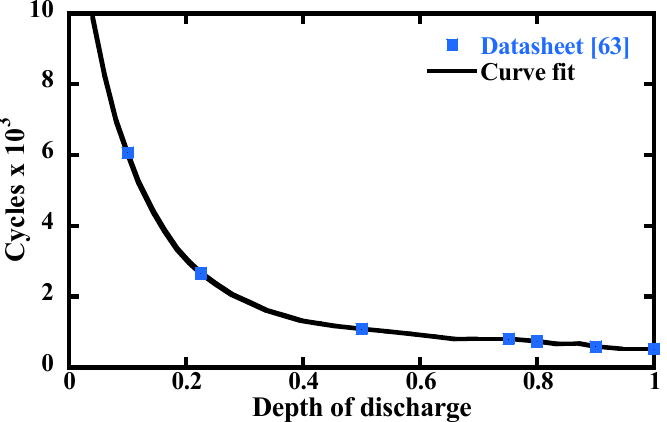
Figure 9. Cycles-to-failure versus DoD for typical deep cycle lead-acid battery [63].